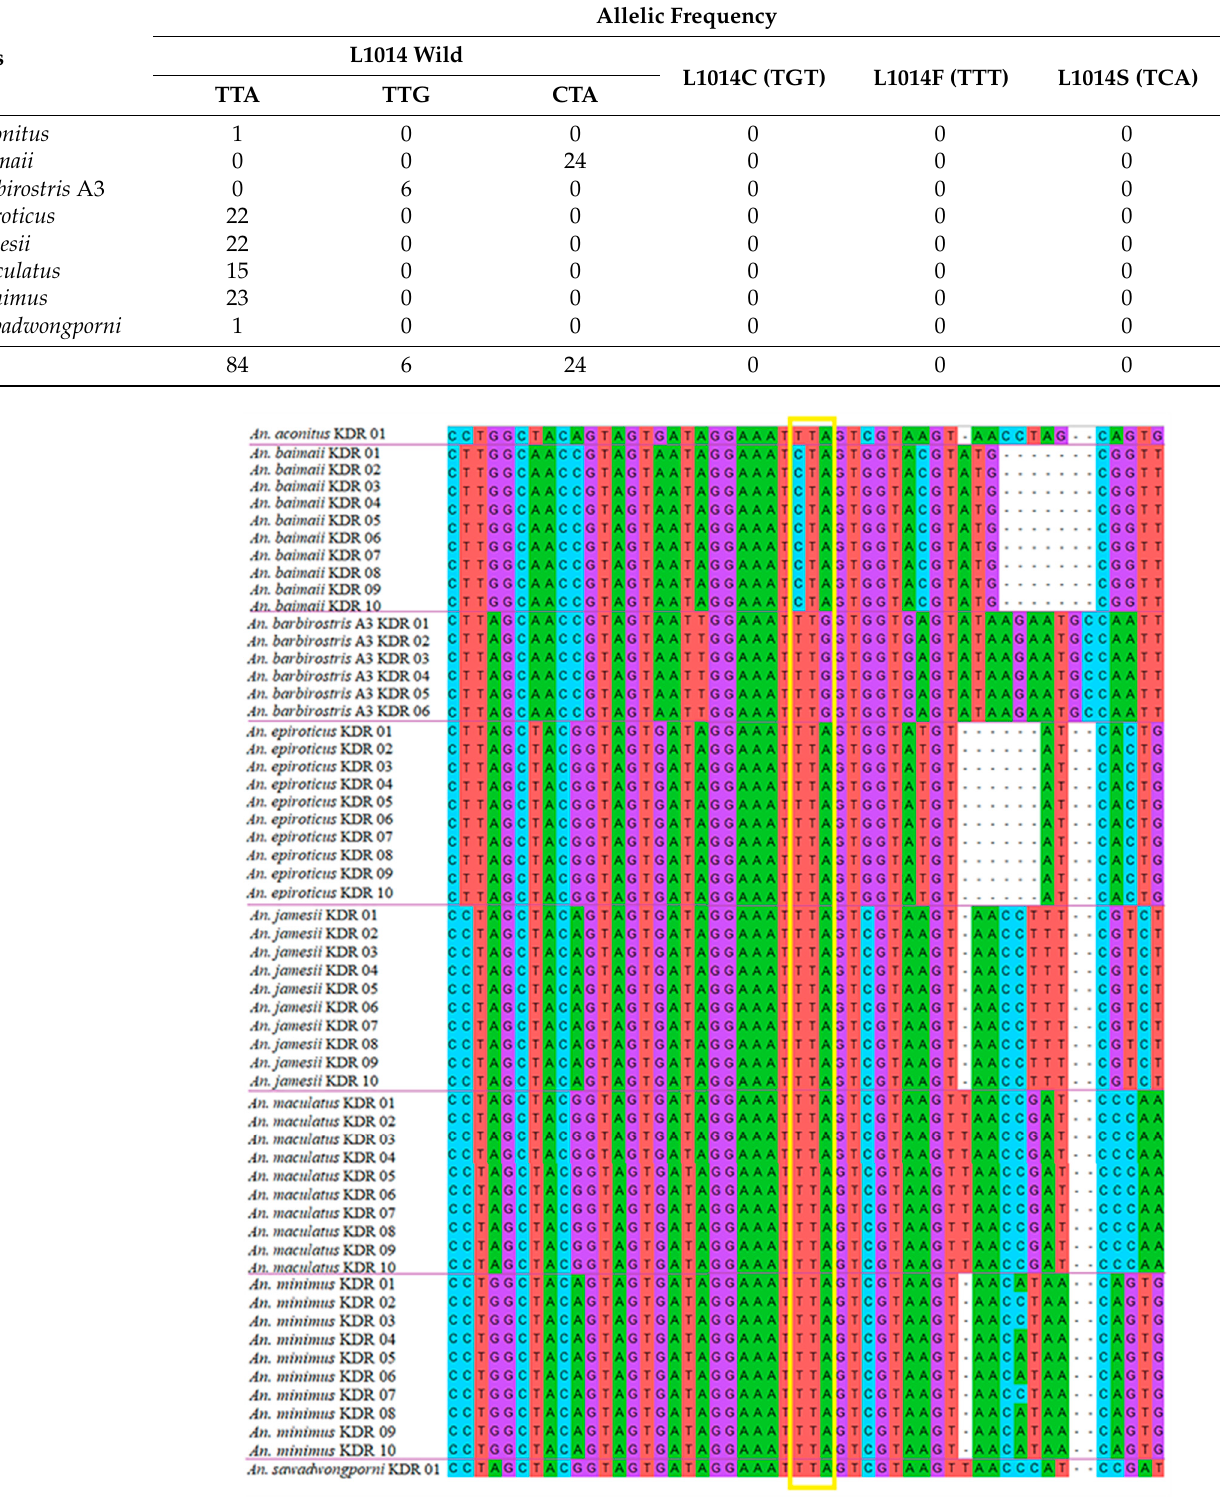
Figure 4. DNA sequences of a voltage-gated sodium channel gene fragment from specimens of the eight Anopheles species sampled in Ranong. The yellow rectangle shows the codon at the 1014 position, for which all samples presented an L1014 wild-type allele (TTA, TTG, or CTA).